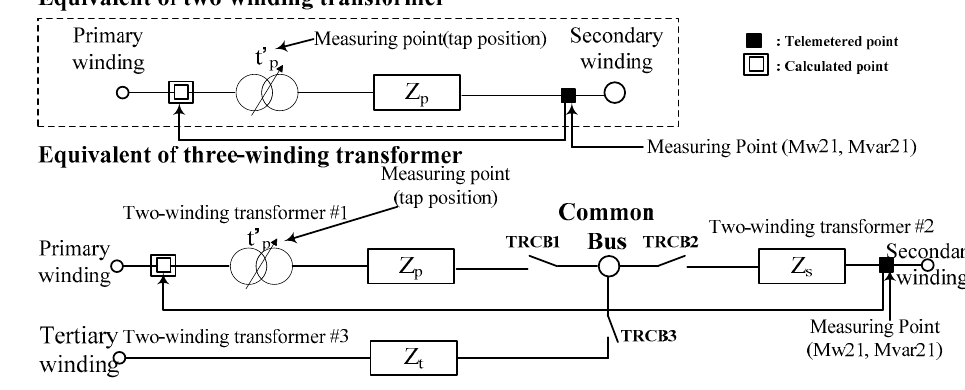
Figure 5. Connectivity model of three-winding transformer [19].